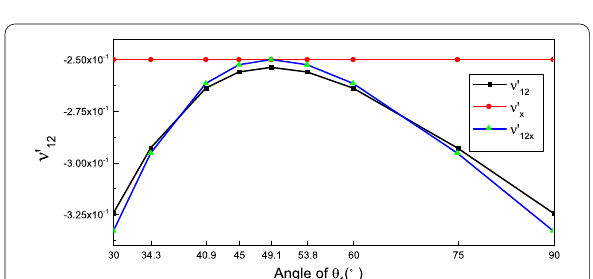
Figure 16 Poisson’s ratio with the variation of angle θ 1 in σ 1 direction